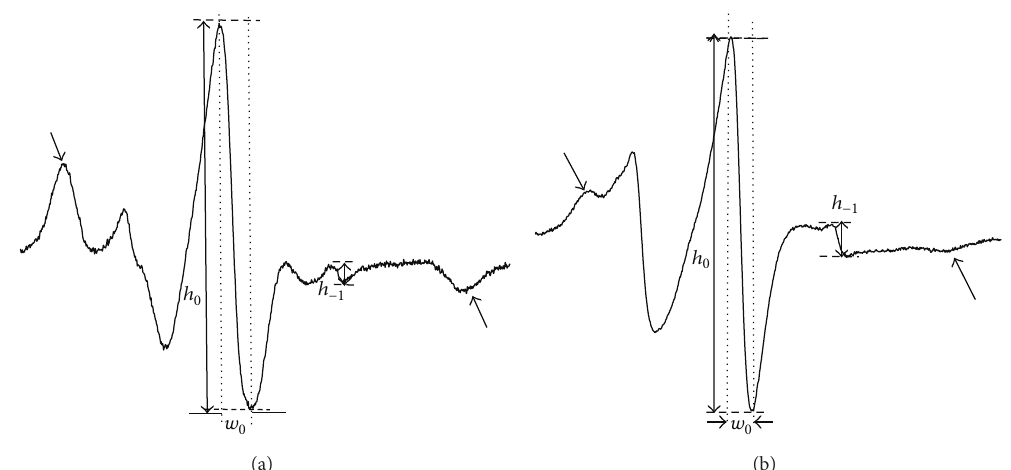
Figure 1: Electron paramagnetic resonance spectrum of (a) 4-maleimido-2,2,6,6,-tetramethylpiperidine-1-oxyl (MSL) and (b) 4-iodoacet- amide-2,2,6,6,-tetramethylpiperidine-1-oxyl (ISL) attached to haemoglobin.